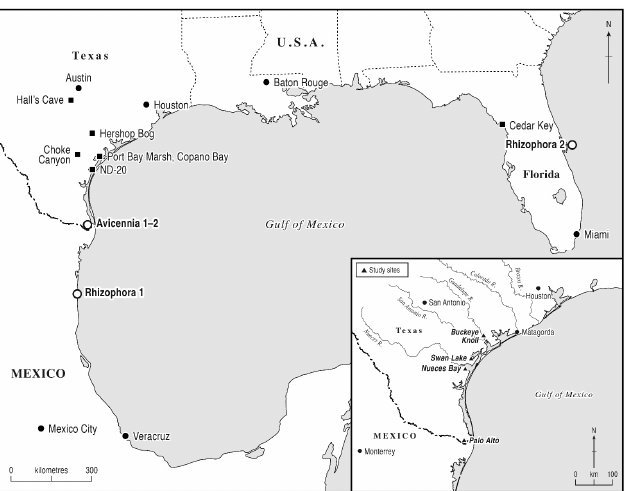
Figure 1. Map of pollen sites in the Texas Gulf Coastal Plain study region (inset, triangles), pollen analog sites (circles) and background sites (squares). analog sites (circles) and background sites